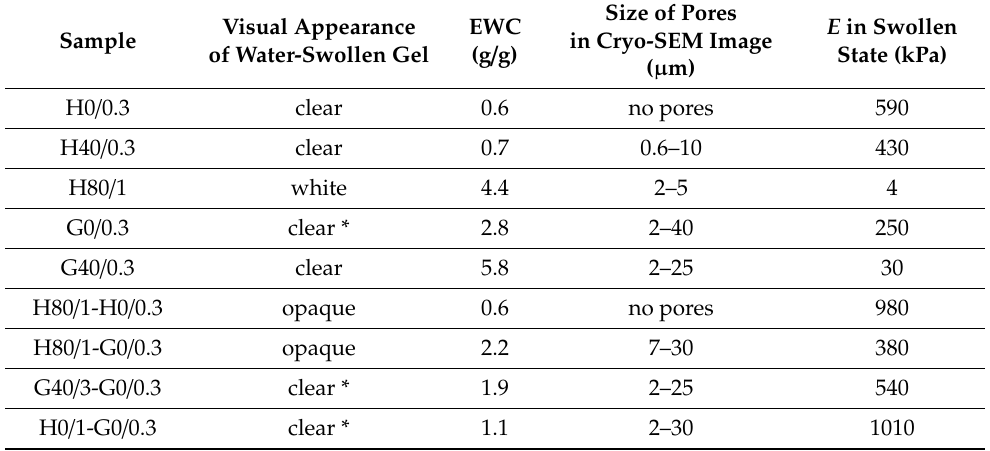
Table 1. Parameters of investigated gels. Visual appearance in equilibrium water-swollen state of gels, equilibrium water content (EWC), Young’s modulus ( E ) and the size of pores detected by cryo-SEM.